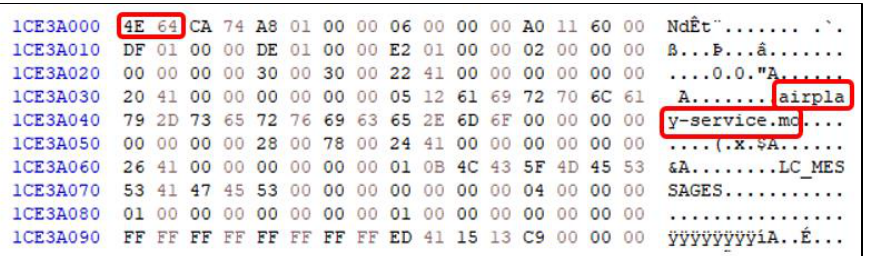
Figure 7. The airplay-service.md file records in a catalog tree with magic number 0x644E.